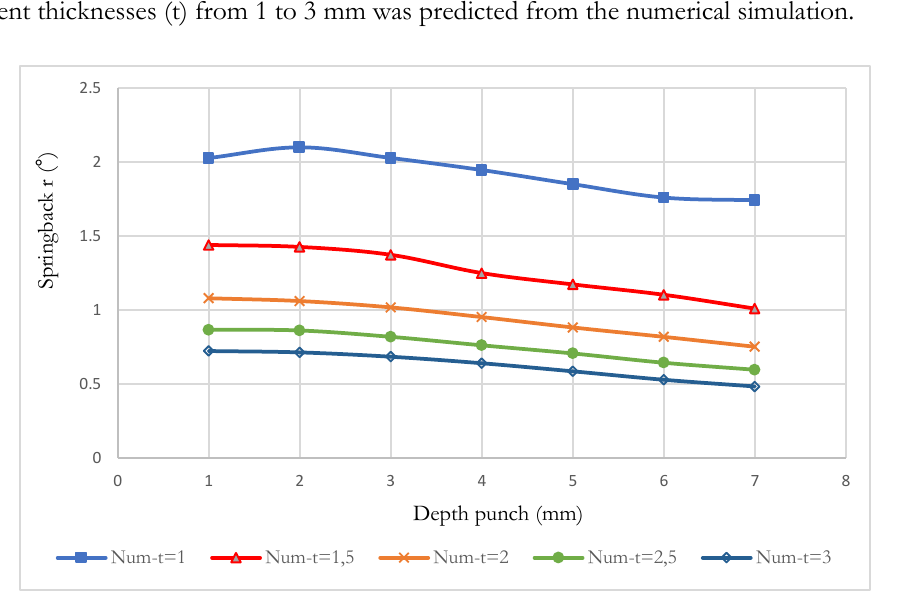
Fig. 8. The evolution of springback (Num.) as a function of depth